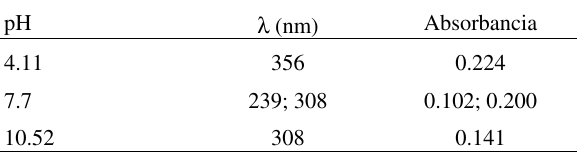
Tabla 1. Resultados de espectroscopia UV-visible de la fase líquida